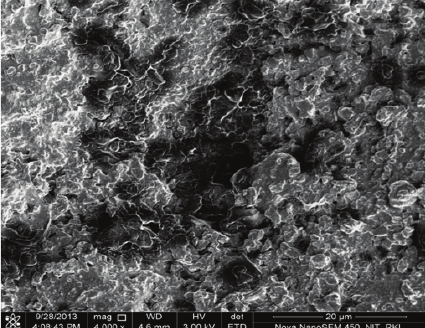
Figure 11: SEM of eroded composite surface (impact velocity 48 m/s, 5 wt% filler, and impact 45 ∘ angle).